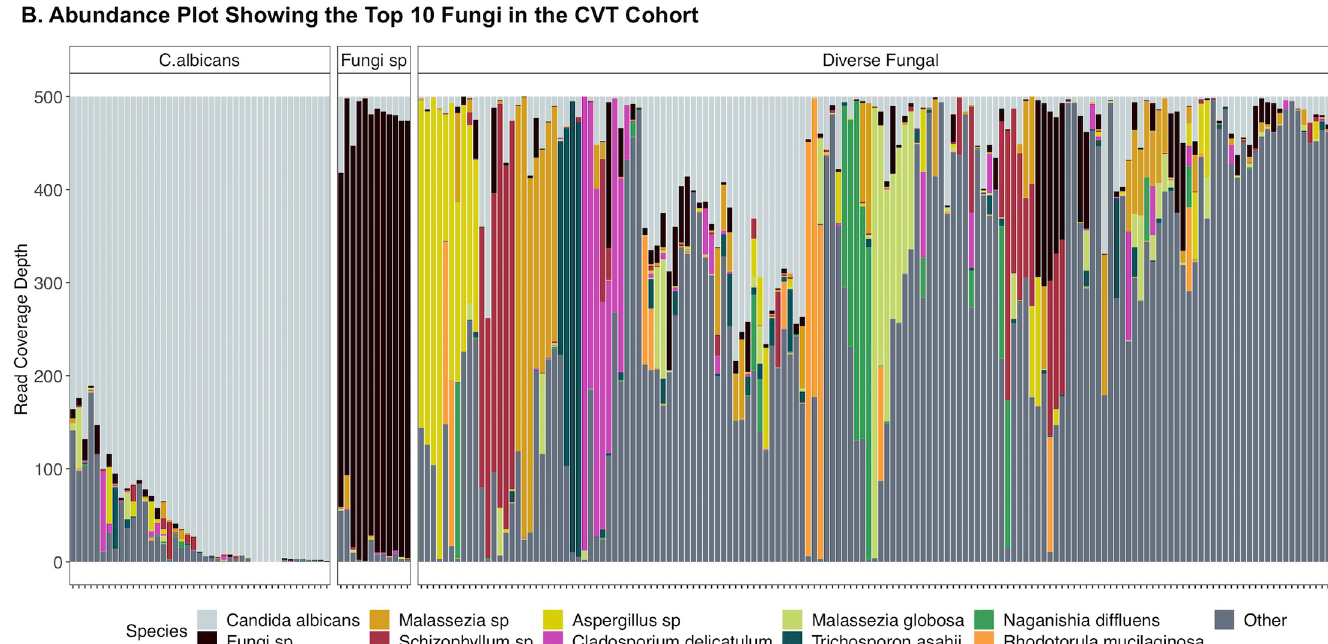
Fig 3. Bacterial and fungal communities within the study cohort. A. The abundance plot represents the bacterial community structure of the study subjects. The operational taxonomic units (OTUs) were collapsed at the species level and the top 10 species are presented. Figure boxes labeled: L. iners, L. crispatus, Gardnerella and Diversity represent the vaginal community state types (CSTs) identified using hierarchical clustering. B. Heatmap showing the top 20 fungal species identified within the study subjects. C . albicans has the highest mean abundance. There were three vaginal fungal community states identified using hierarchical clustering as indicated by the separate